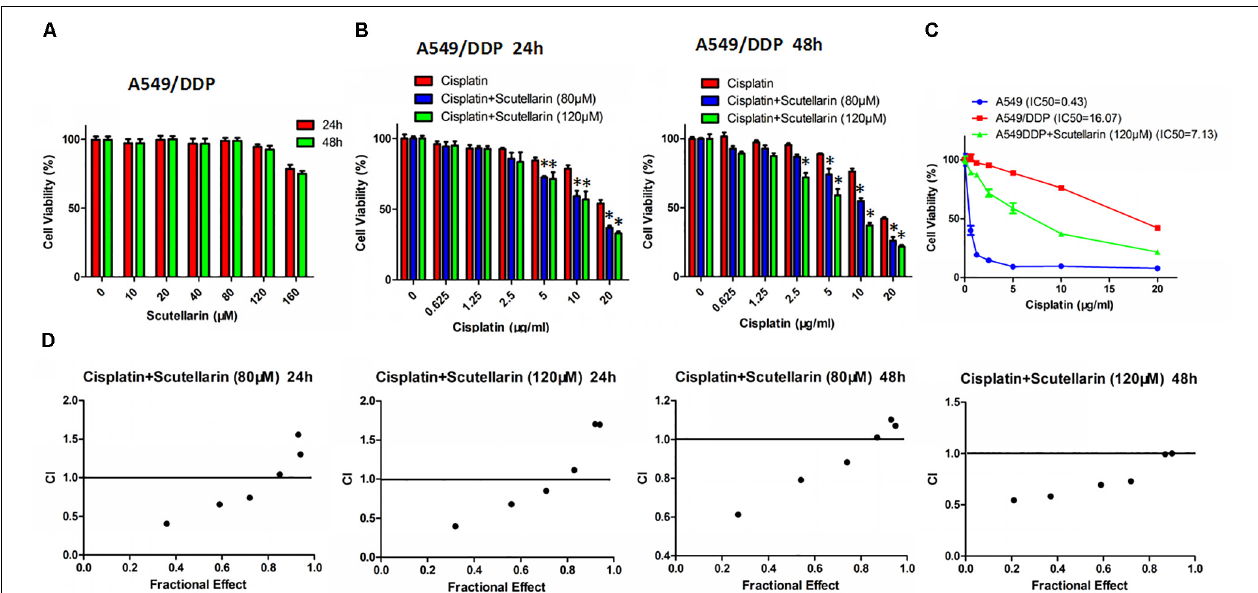
FIGURE 1 | Scutellarin enhanced the drug susceptibility of cisplatin in A549/DDP cell. (A) A549/DDP cells were treated with different concentrations of scutellarin for 24 or 48 h, the cell viability was determined by the MTT assay. (B) Cells were treated with cisplatin combined with scutellarin (80 or 120 µ M), cell viability was measured by the MTT assay. (C) The sensitivity of A549 and A549/DDP to cisplatin was measured by MTT assay, and 120 µ M scutellarin reduced IC50 of cisplatin in A549/DDP cells. (D) Drug synergism are expressed as fraction affected (Fa) curves and combination index (CI) plots. CI as a indicator of synergistic effects of cisplatin and scutellarin (additive effect, CI = 0.9–1.1; slight synergism, CI = 0.7–0.9; synergism, CI = 0.3–0.7; strong synergism, CI = 0.1–0.3). ∗ p < 0.05.